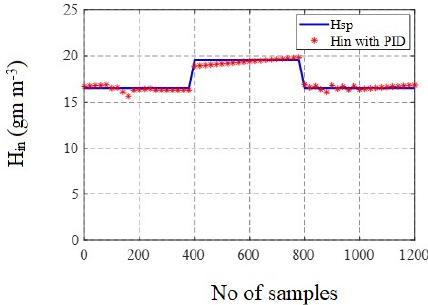
Figure 25. Experimental Results of Relative Humidity H in .